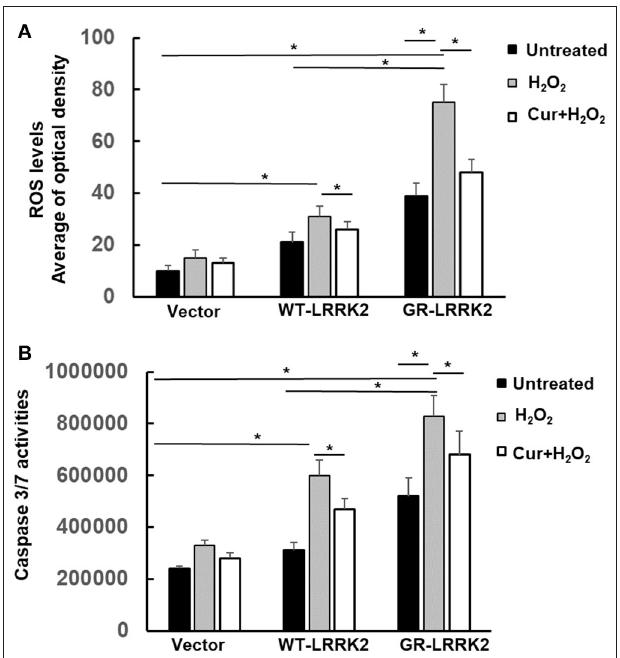
FIGURE 5 | Curcumin reduced H 2 O 2 and G2385R-LRRK2-induced mitochondrial ROS and caspase-3/7 activation. SH-SY5Y cells were co-transfected with vector or various LRRK2 constructs with or without a subtoxic dose of H 2 O 2 exposure and curcumin (1 µ M) for 12–48h. (A) Mitochondrial ROS in each group was measured at 12h after treatment of H 2 O 2 and curcumin. (B) Caspase-3/7 activities were measured at 48h after treatment of H 2 O 2 and curcumin. * p < 0.05, statistical significance between groups as indicated.